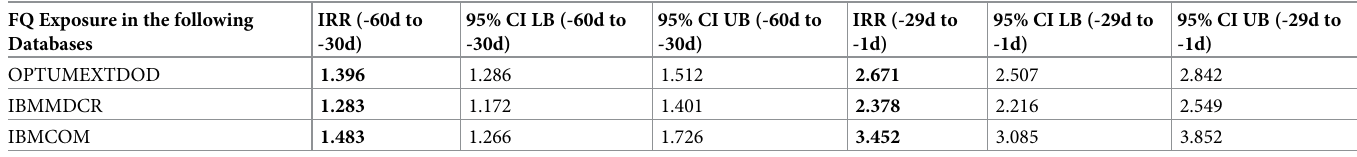
Table 2. Incidence rate ratios for AAD in two intervals prior to FQ exposure using SCCS design that is adjusted for seasonality and age, in each database. FQ Exposure in the following Databases